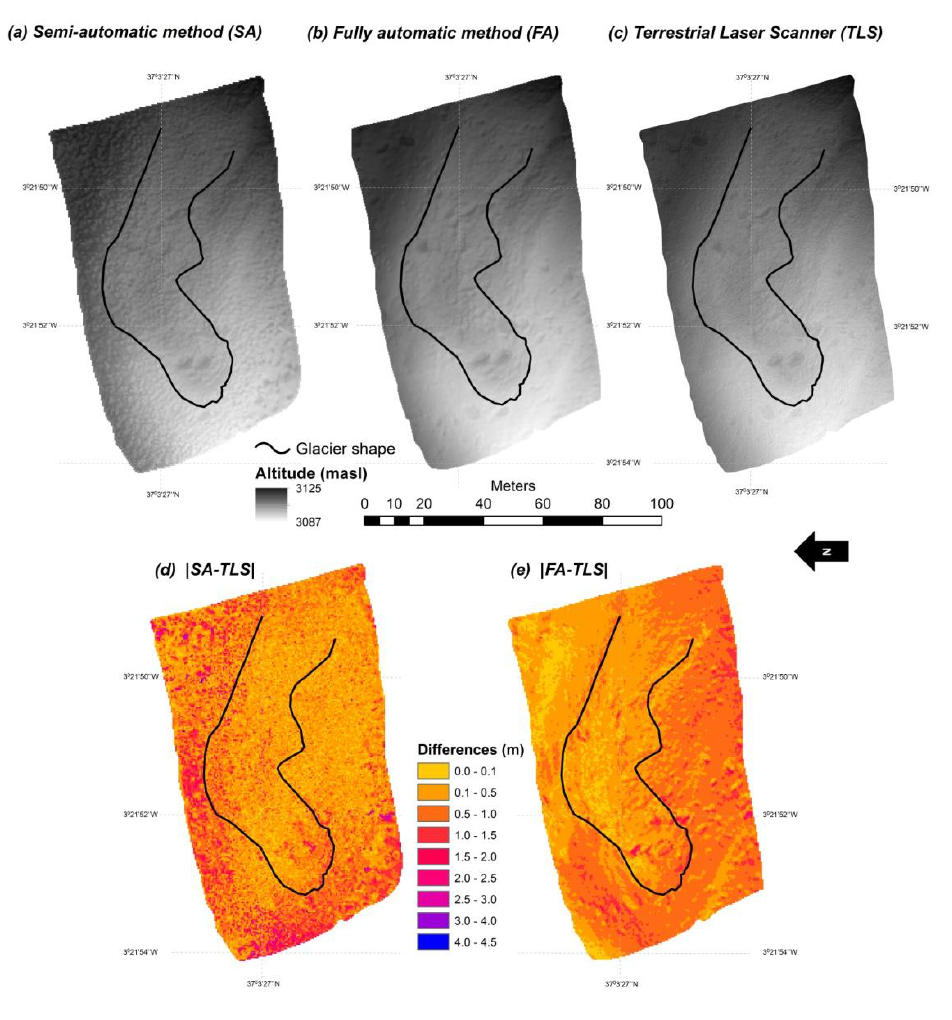
Figure 5. DEMs elaborated with the point clouds obtained by means of the ( a ) Semi-Automatic (SA), ( b ) Fully Automatic (FA) and ( c ) Terrestrial Laser Scanner (TLS) methods, respectively, and the absolute differences between the SA, the FA DEMs and the TLS DEM, ( d , e ) respectively. A transparency of 10% was applied to the DEMs in (a–c) and a hillshade digital model generated by every DEM that was used as a base in order to improve visualization of the glacier